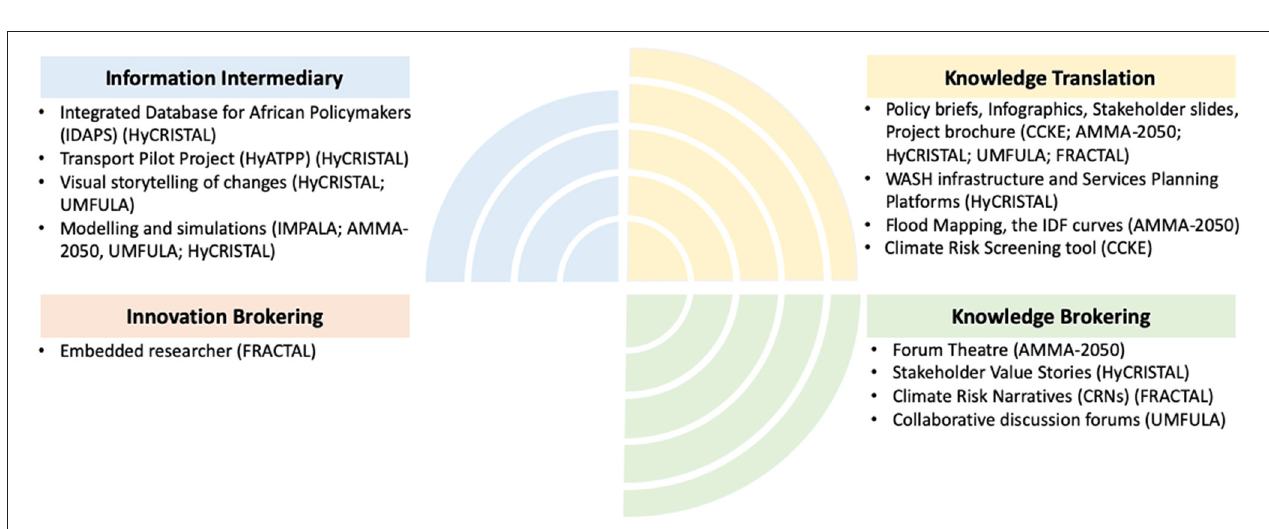
FIGURE 2 | Stages and indicative strategies for user engagement in knowledge co-production.